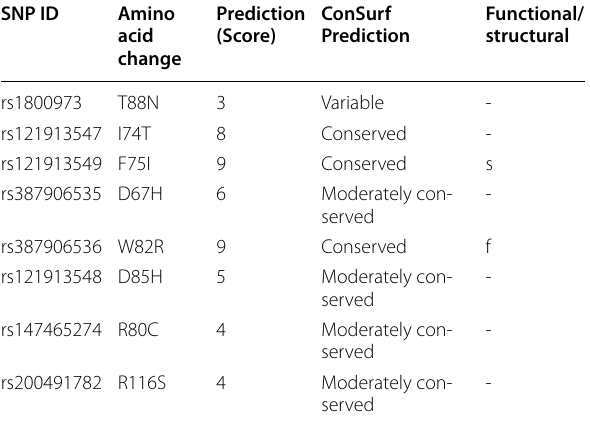
According to the ConSurf server, “f” — functional residue and “s” — structural